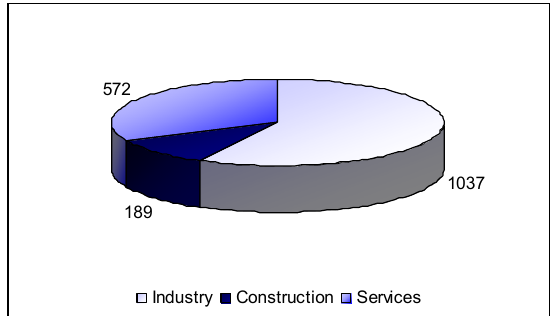
Figure 2 - The number of enterprises with innovation activity according to the sector of their operation in Slovak